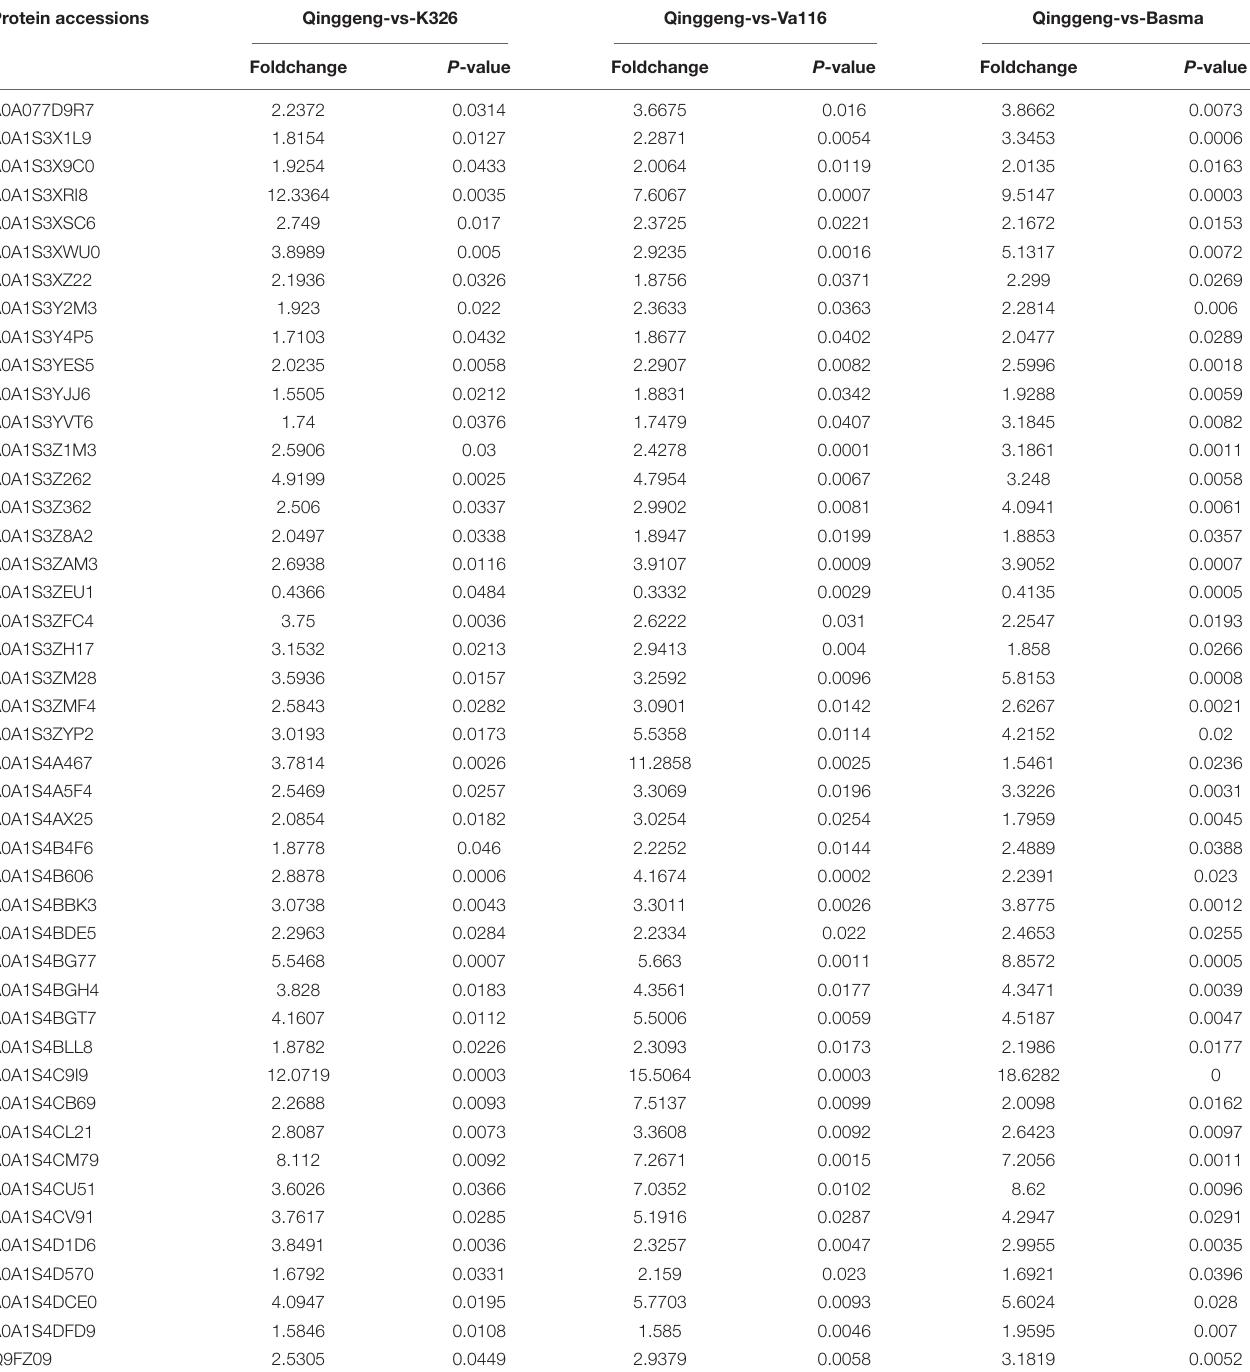
TABLE 1 | Verification of 45 candidate proteins relating to nicotinic content by data-independent acquisition (DIA) proteomics. Protein